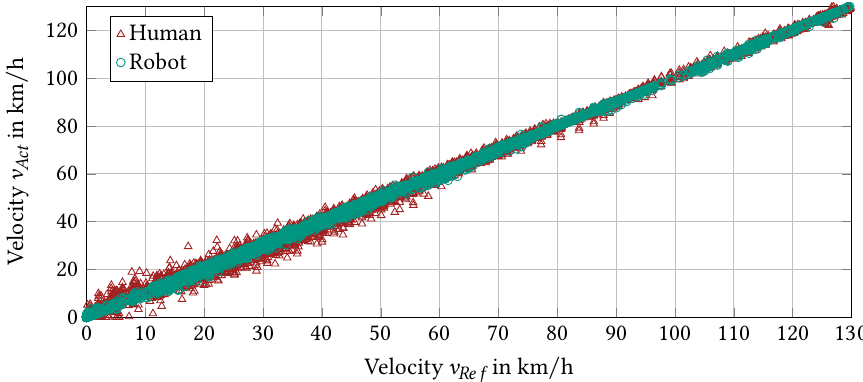
Figure 8. Velocity distributions of the human driver and the driving robot in a